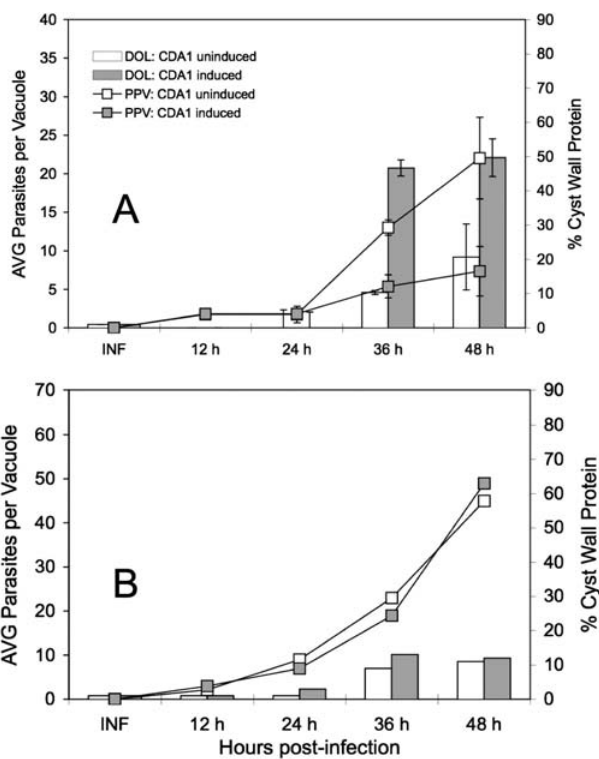
Figure 4. Overexpression of CDA1 in Infected Cells Slows Parasite Growth and Induces Bradyzoite Development (A) HeLa cells expressing the tetracycline repressor protein transfected with the pcDNA4 TO-CDA1 plasmid inhibit parasite growth and induce cyst wall protein when grown in media containing tetracycline to induce expression of the CDA1 transgene. Compare parasite growth in transfected HeLa cells cultured without tetracycline (growth measured as average parasites per vacuole, PPV, open box with lines) with that of parasite growth in media containing tetracycline to induce CDA1 expression (shaded box with lines). Concurrent with the observed inhibition of parasite replication, cyst wall protein was also expressed. Compare background levels of cyst wall protein (light bars) with levels induced by overexpression of CDA1 (dark bars) at 36 and 48 h. Treatment of HeLa cells with tetracycline alone, transfection of HeLa cells with the pcDNA4 TO expression vector alone, or transfection of HeLa cells with the pcDNA4 TO vector and induced to expressed the coding sequence for yellow fluorescent protein (YFP) were all unable to slow parasite growth or induce the expression of cyst wall protein (unpublished data). (B) Early passage type I GT-1 parasites (fewer than 12 passages from the oocyst) do not slow growth or initiate the expression of bradyzoite- specific cyst wall protein in a cell expressing CDA1 under control of the tetracycline-inducible promoter. Compare parasite growth and cyst wall protein measured by immunofluorescence in uninduced cells (open boxes, light bars) with growth and cyst wall protein in cells ectopically expressing the CDA1 protein (shaded boxes, dark bars). DOI: 10.1371/journal.ppat.0020105.g004